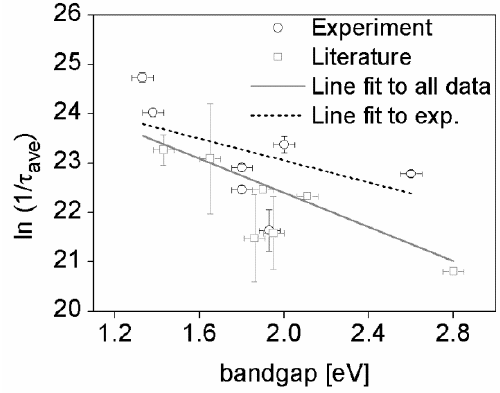
Figure 2. The natural logarithm of the rate of singlet exciton decay plotted as a function of optical bandgap for 16 conjugated polymer films included in Table 1. The open circles represent the experimentally determined rates of exciton decay of the polymer films studied, estimated using ultrafast transient absorption spectroscopy. The error bars represent the square root of the mean residual variance of the exciton lifetime as received from the exponential fits of the exciton decays. The open squares represent the rates of exciton decay for popular polymers as extracted from the literature. The error bars represent the standard deviation of the exciton lifetimes found in the literature for each polymer. The black line is the best fit straight line to all data points showing a negative slope and the broken line is the best fit straight line to the seven polymers characterized herein.